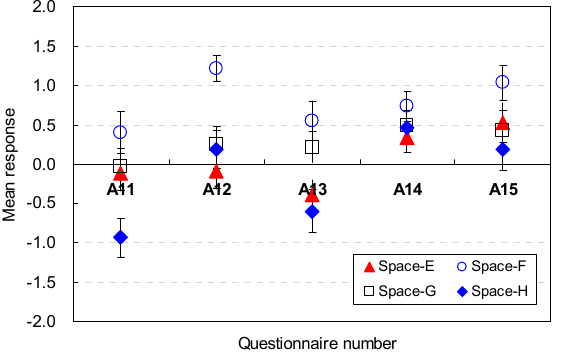
Figure 10. Spatial perception of the spatial configuration in terms of amenity under floor layout changes.